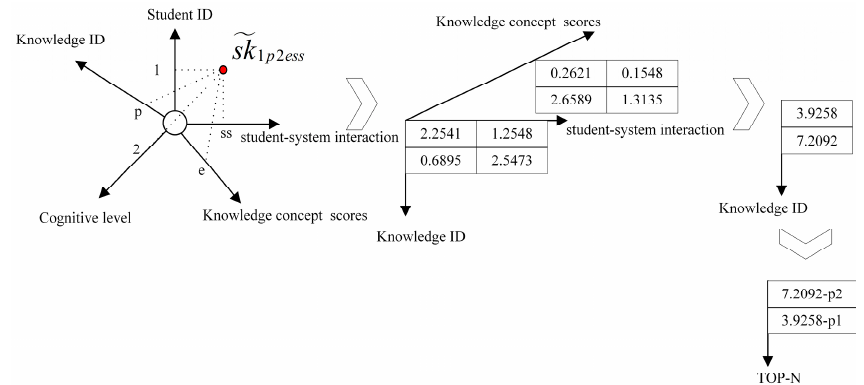
Figure 5. Examples of recommended knowledge concepts .